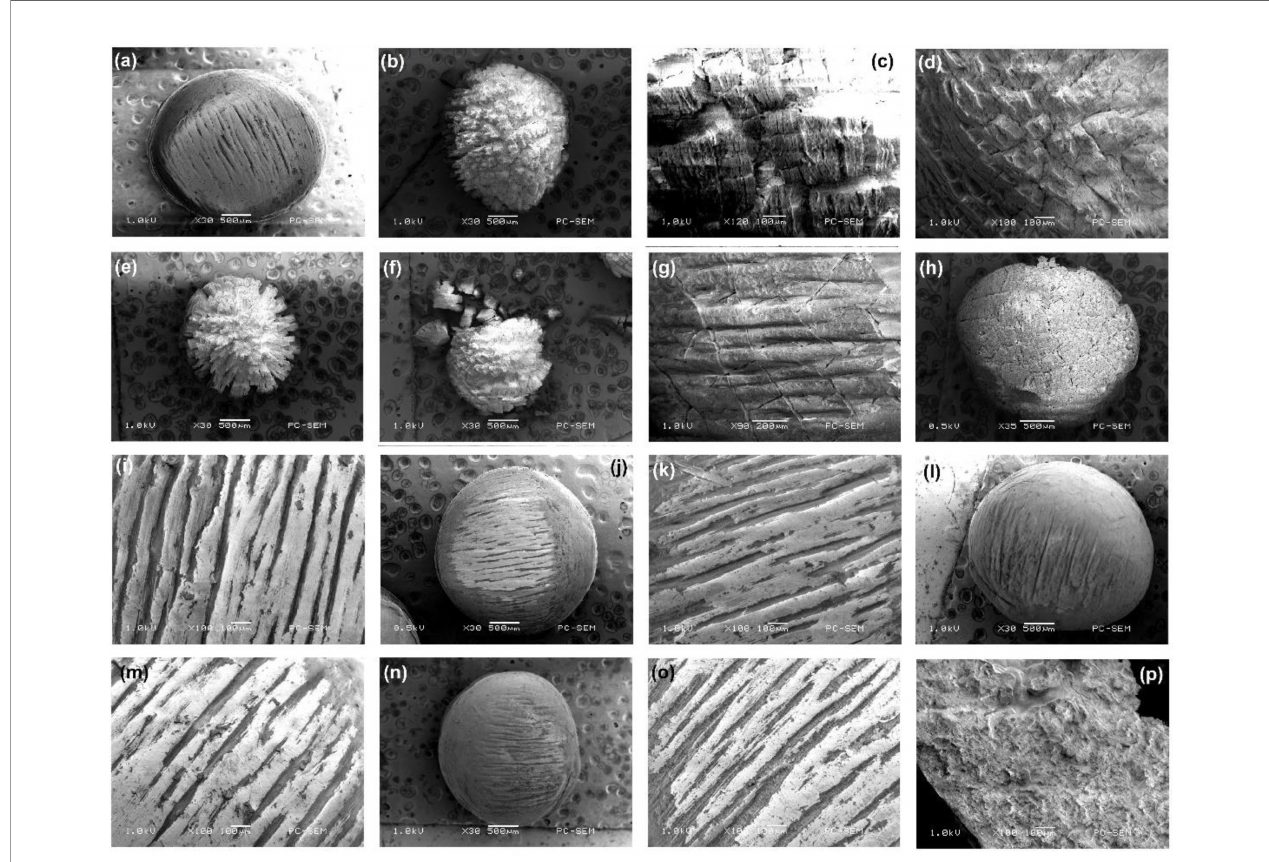
smaller (typically ~ 2.5 mm), losing material, and as shown in Figure 1B . The surface is indented with deep cracks that form knobby, yet angular features as “ islands ” , some 100 µm across. The size suggests that the cracks have formed at the scale of the original striations. Higher magni fi cation ( Figure 1C ) shows fi ner level cracking with a spacing of about 15-30 µm. After three years the cracks penetrate even more deeply into the pellet ( Figures 1D, E ) and the size has decreased further (~1.27 mm) and by 3.5 years ( Figure 1F ), the pellets are so degraded